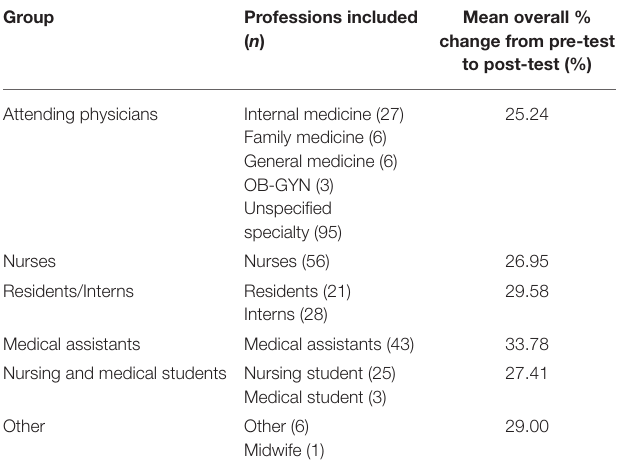
TABLE 2 | Categories of professions and their respective mean overall % change in knowledge score. Group